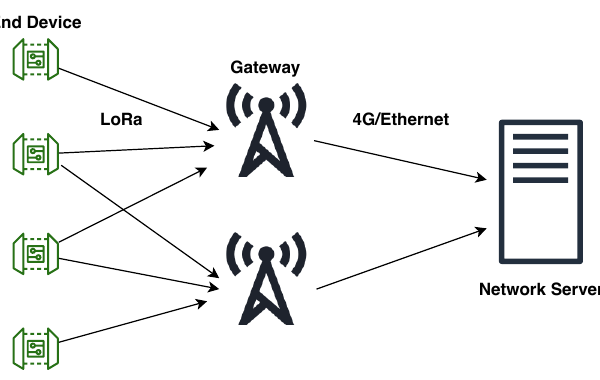
Figure 2. LoRaWAN architecture.